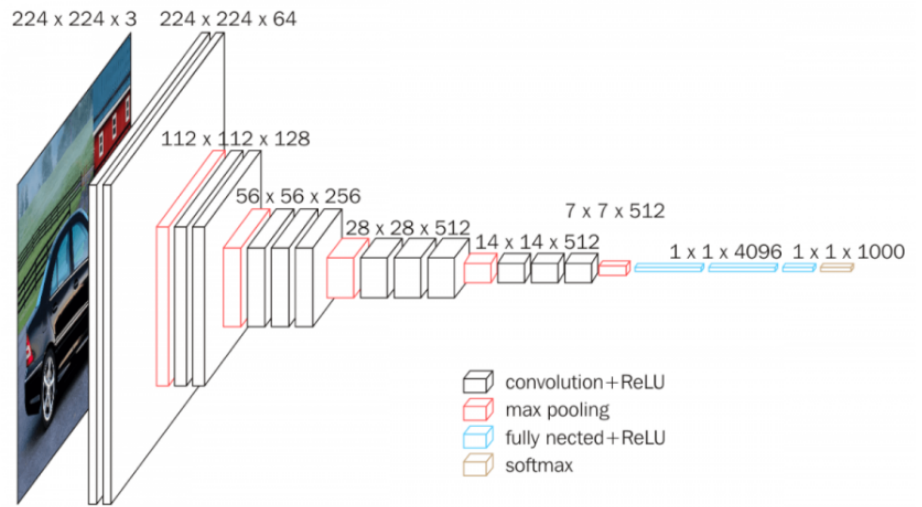
Figure 4. Schematic diagram of the VGG16 CNN architecture. Credit: https://neurohive.io/en/ popular-networks/vgg16/ (accessed on 15 November